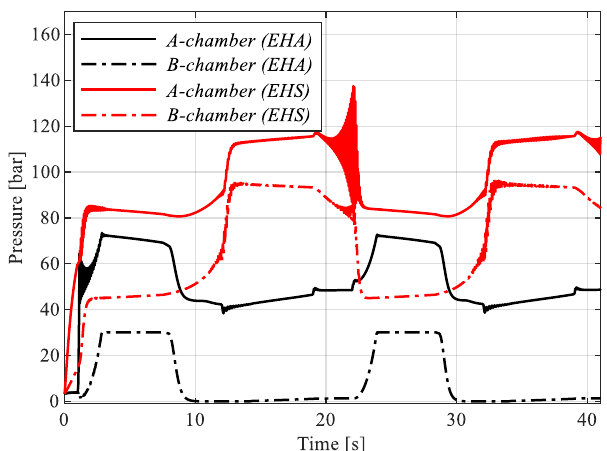
Figure 18. Pressure levels in the cylinder chambers for electro-hydrostatic actuator system (EHA) x electro hydraulic system (EHS).